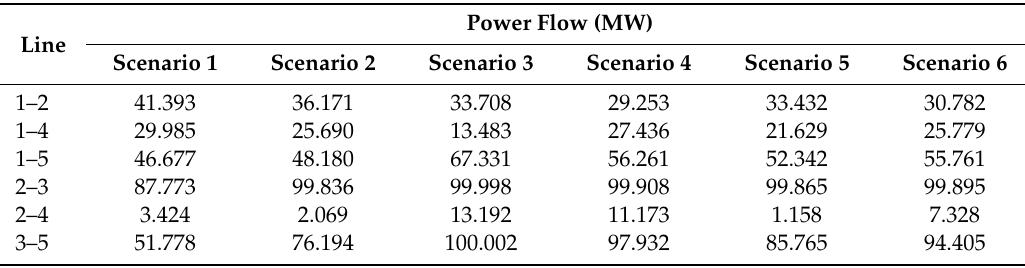
Table 10. Power flows before